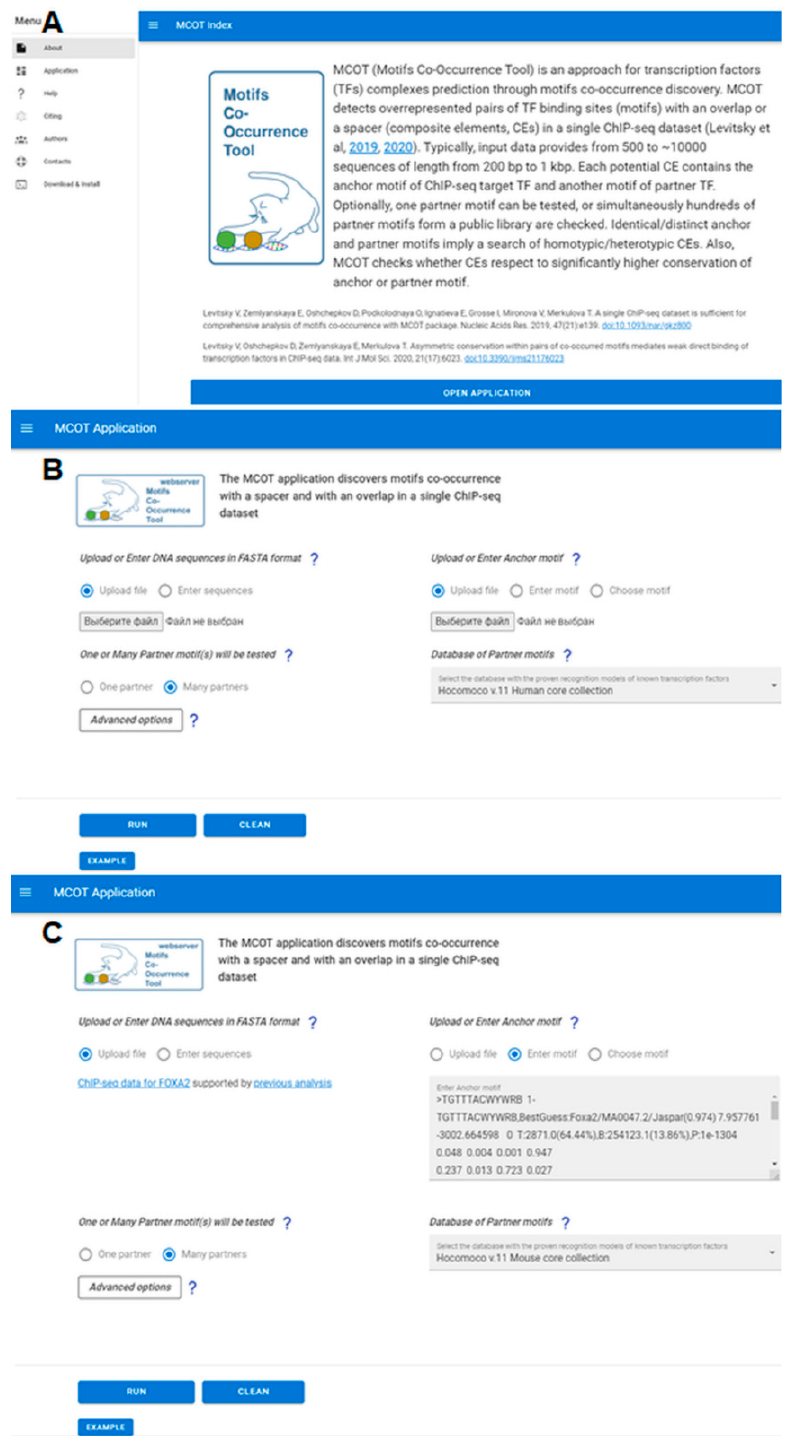
Figure 1. Basic Web-MCOT pages: ( A ) homepage, ( B ) application, and ( C ) example.